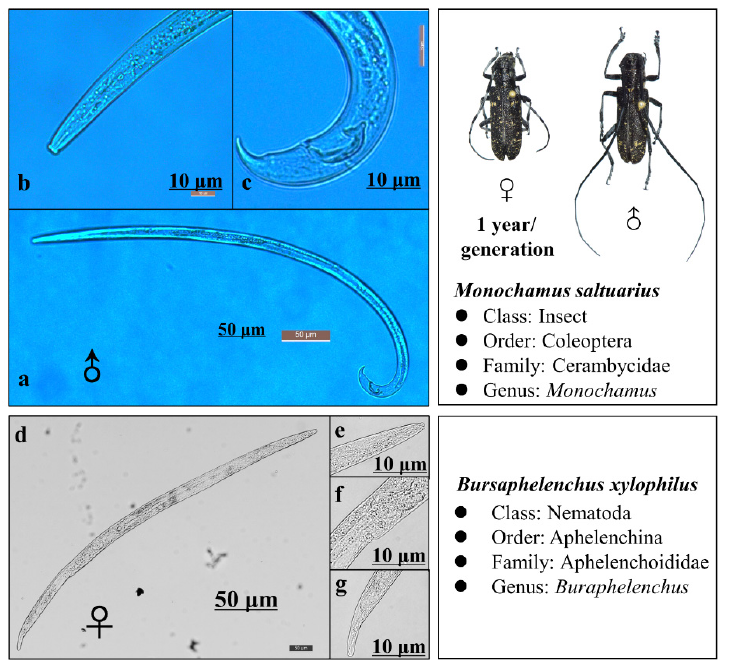
Figure 4. The morphology of Monochamus saltuarius and the pine wood nematode (PWN). ( a ) Male adult PWN; ( b ) head of the male PWN; ( c ) tail of the male PWN; ( d ) female adult; ( e ) head of the female PWN; ( f ) vulva of the female PWN; ( g ) tail of the female PWN.